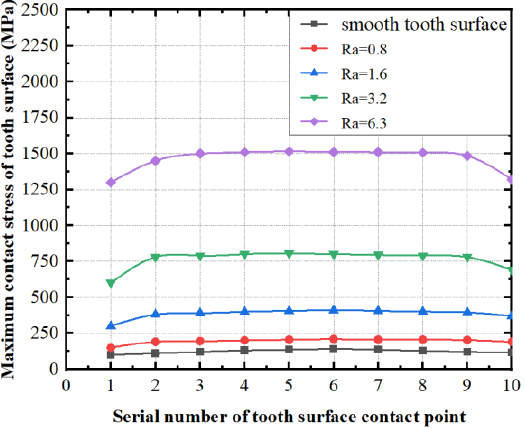
Figure 11. The curve of greatest contact stress at the contact point of the face